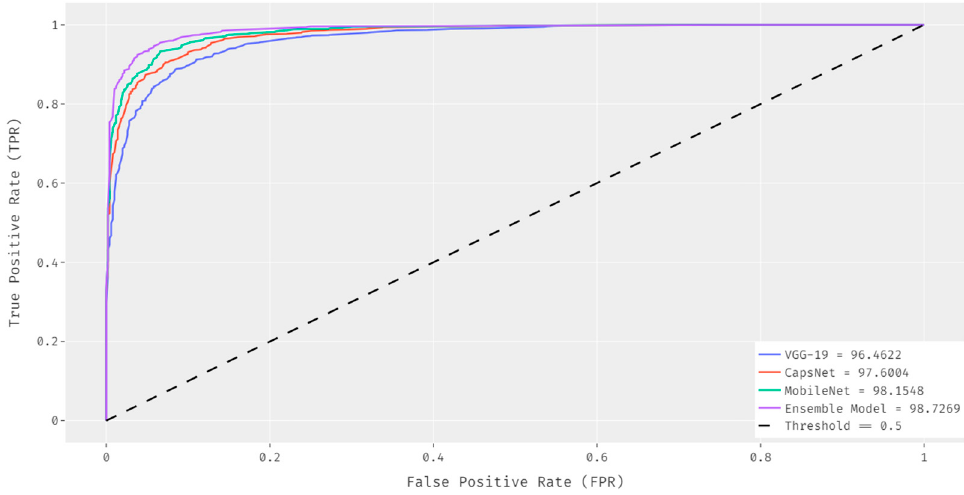
Figure 10. ROC analysis of EDL-MMLCC model.